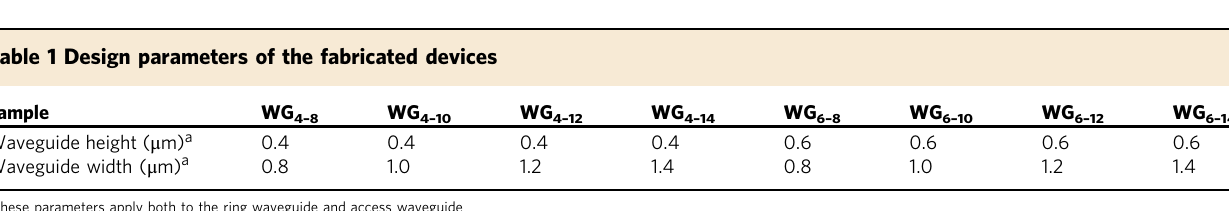
Fig. 2 Numerically calculated fi eld component distributions and their dependence on waveguide dimensions. a The cross-sectional fi eld distribution of the transverse component E trans of the fundamental quasi-TE mode in a SiN x waveguide, and the dashed rectangular indicates the waveguide of 0.8 μ m width and 0.6 μ m height. The results in b and c are obtained with the same waveguide mode. b The fi eld distribution of the longitudinal component (multiplied with the imaginary unit) iE long . c The distribution of the component ratio iE long / E trans over the waveguide cross section and evanescent region. d The contour map of the ratio iE long / E trans over variable waveguide dimensions. Among all the waveguide designs calculated, eight waveguide dimensions marked in the map are employed for device fabrication and characterization, consisting of two different heights (0.4 and 0.6 μ m) and four widths (0.8, 1.0, 1.2, and 1.4 μ m) as indicated in the subscripts